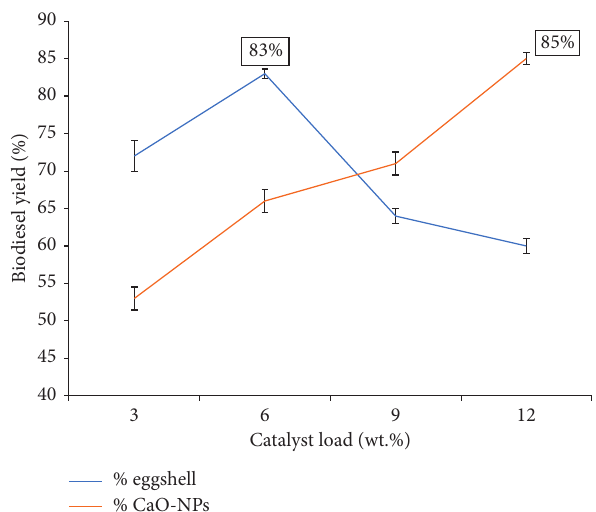
Figure 13: The effect of the amount of catalyst on the production of